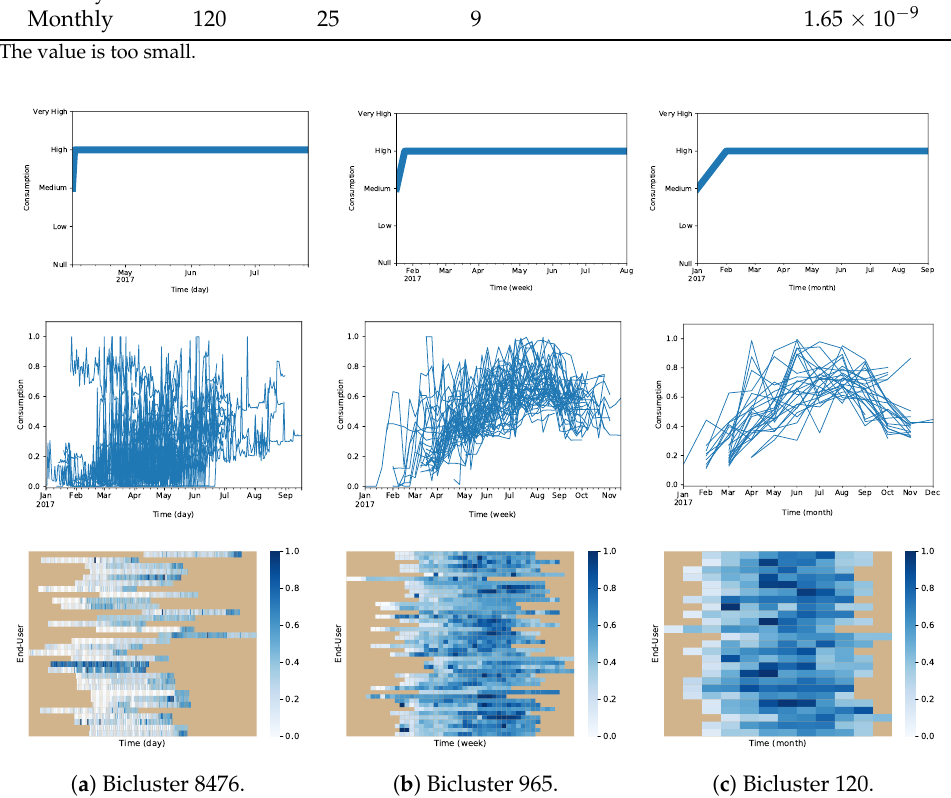
Figure 25. Illustration of the selected biclusters allowing time-lagged patterns (Bicluster 8476, Biclus- ter 965, and Bicluster 120) found on the daily, weekly and monthly dataset. This figure shows the consumption patterns on the first row, the user consumption scaled time series on the second row, and the scaled data heatmap on the third